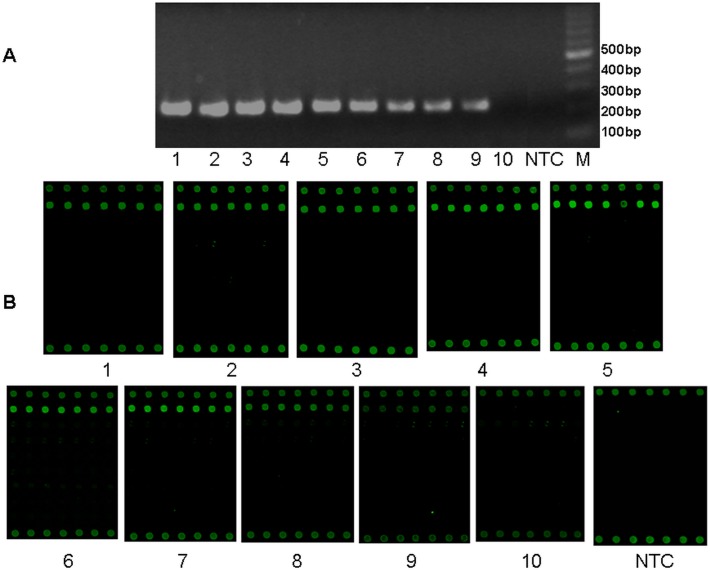
Detection sensitivity of multiplex-PCR-microarray for HHVs.The detection sensitivity was estimated for HHVs (HSV1) by multiplex RT-PCR and microarray. A. Multiplex RT-PCR result from serial diluted recombinant HSV1 control; B. The microarray result after amplification and hybridization. M: 1 Kb DNA ladder; NTC: no template control. Numbers 1–10: Serial 10-fold dilutions of recombinant HSV1 control. 1: 6×108copies/μl; 2: 6×107copies/μl; 3: 6×106copies/μl; 4: 6×105copies/μl; 5: 6×104copies/μl; 6: 6×103copies/μl; 7: 6×102copies/μl; 8: 6×101copie/μl; 9: 6×100copies/μl; 10: 6×10–1copies/μl.